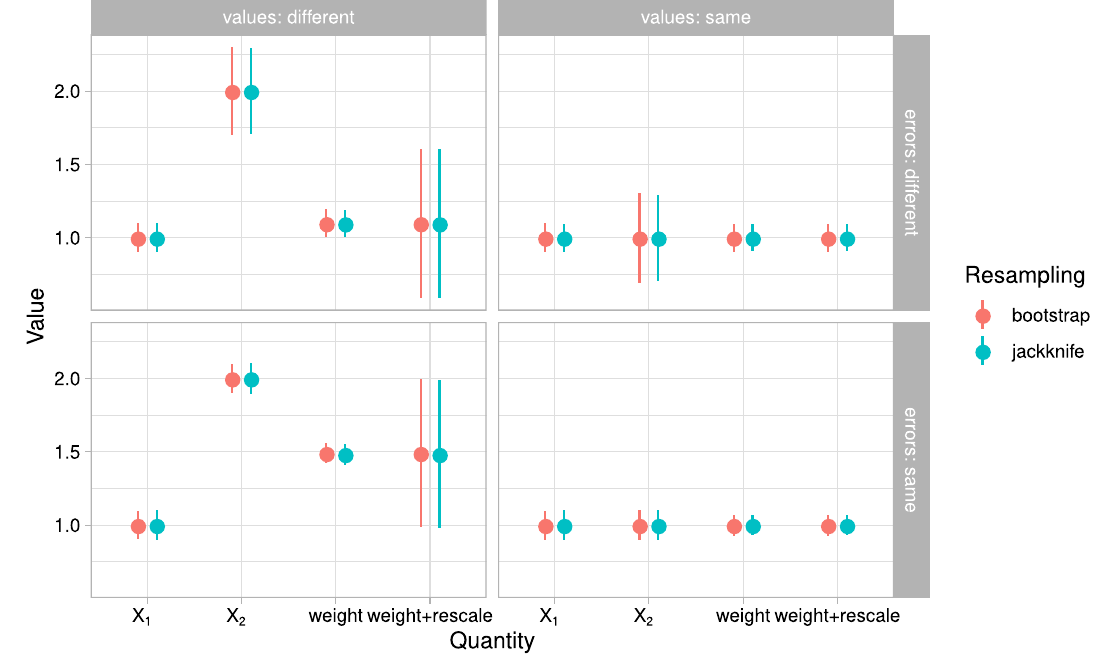
Fig. 8 Combination of artificial fit results from two different methods to a weighted average and finally the rescaled distribution. Columns show different and same central values, rows show different and same statistical errors in the two